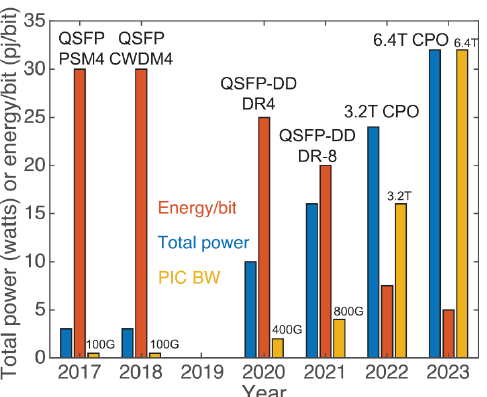
Figure 3. The evolution of PIC bandwidth, power efficiency, and total power consumption [22] .